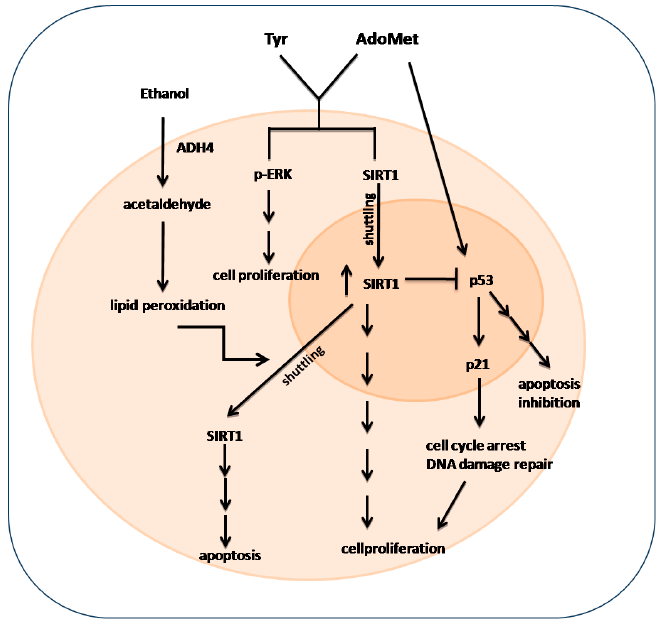
Figure 4. The addition of Tyr and AdoMet to hepatocellular carcinoma cells after acute ethanol treatment increases pERK expression that, in turn, determines increased cell proliferation. The treatment also induces an increase of nuclear Sirt1 expression that both promotes cell proliferation itself and blocks the p53/p21 pathway with consequent apoptosis inhibition.